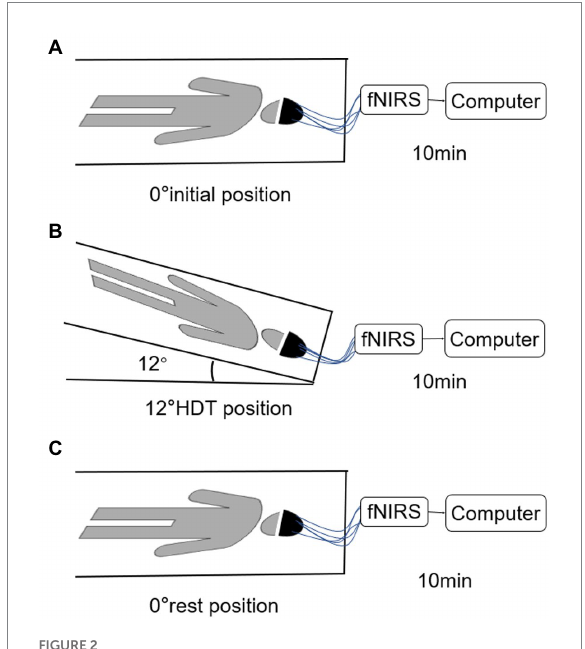
FIGURE 2 (A–C) are the position diagram of each stage of test